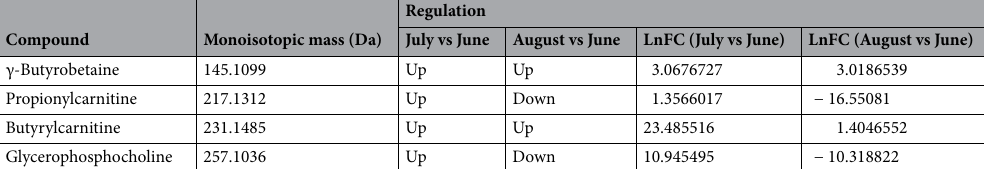
Table 4. Metabolites obtained from LC–MS data (positive mode), that are differentially accumulated in milk samples from buffaloes of ZG Group (fed TMR + 30% of green forage) for the whole experimental period (June, July and August). Identifications were performed by comparing results with known compounds present in freely available electronic databases. Milk Composition Database (MCDB) and Bovine Metabolome Database (BMDB)were used for the identification. Up, up regulated; Down , down regulated. LnFC , Natural logarithm of Fold Change.